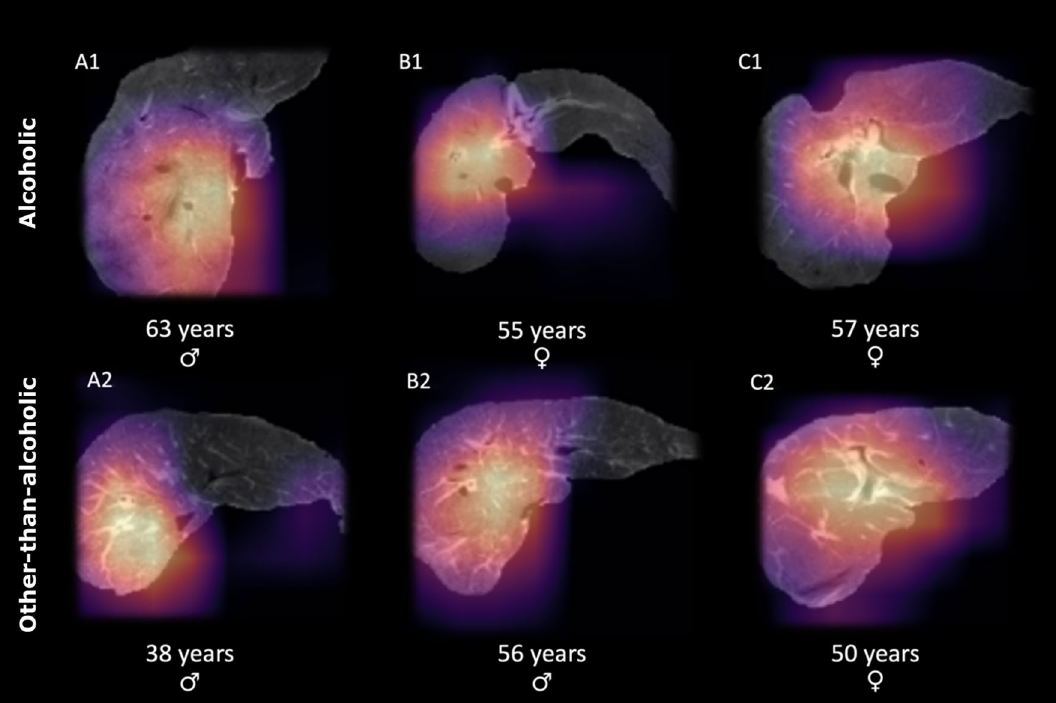
Figure 3. Exemplary images from the study population. ResNet50 trained with unfrozen pre-trained parameters was used for the classification task. Exemplary patients from the test set are provided and imaging regions that were particularly relevant to the classification task are highlighted using the gradient-weighted class activation maps (Grad-CAM) method. Panels A1, B1, C1 provide exemplary patients from the test set